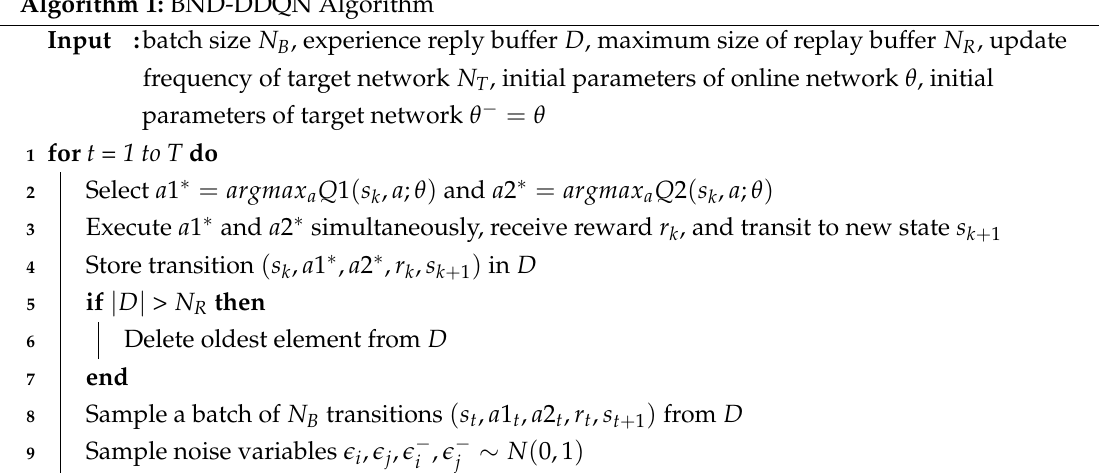
Algorithm 1: BND-DDQN